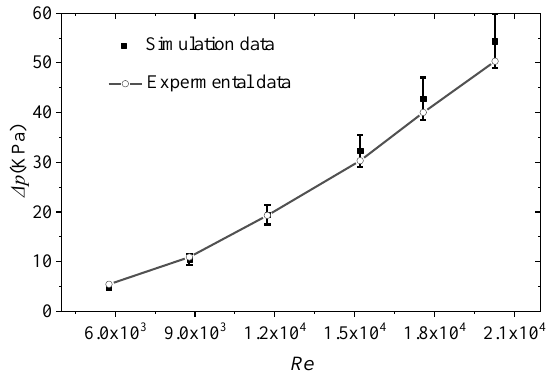
Figure 12. Validation of pressure drop for different Re.